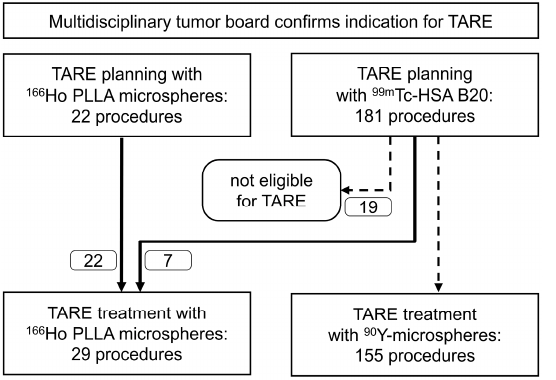
Figure 4. Over a period of 30 months, 203 TARE planning and 184 TARE treatment procedures were performed. All procedures involving 166 Ho PLLA microspheres were consecutively included in the study.